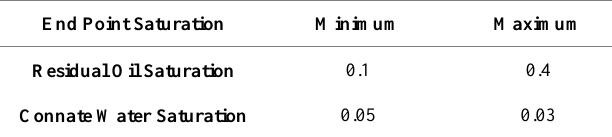
Table 6. Range of endpoint saturations used in generation of relative permeability